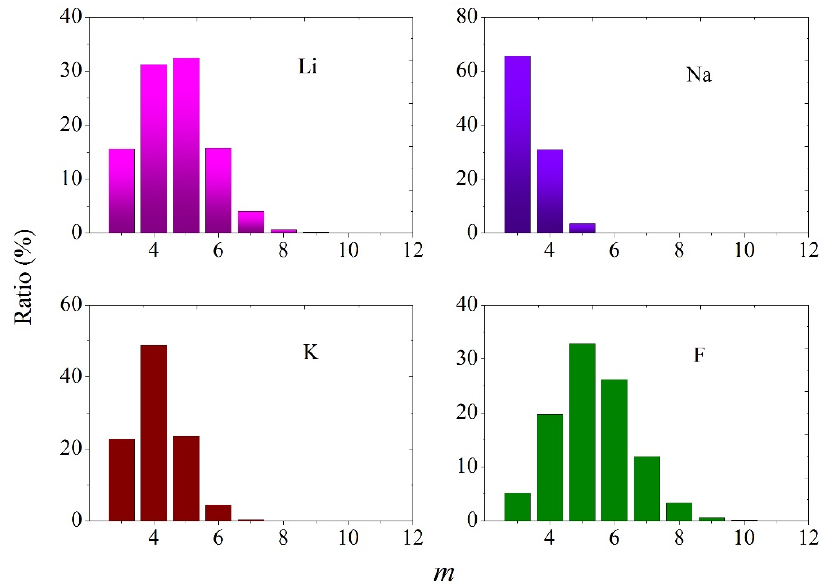
Figure 11. The distribution of faces of Voronoi polyhedra by the number of sides for the Li, Na, K and F subsystem of molten salt mixture FLiNaK+CeF 3 at a temperature of 950 K.